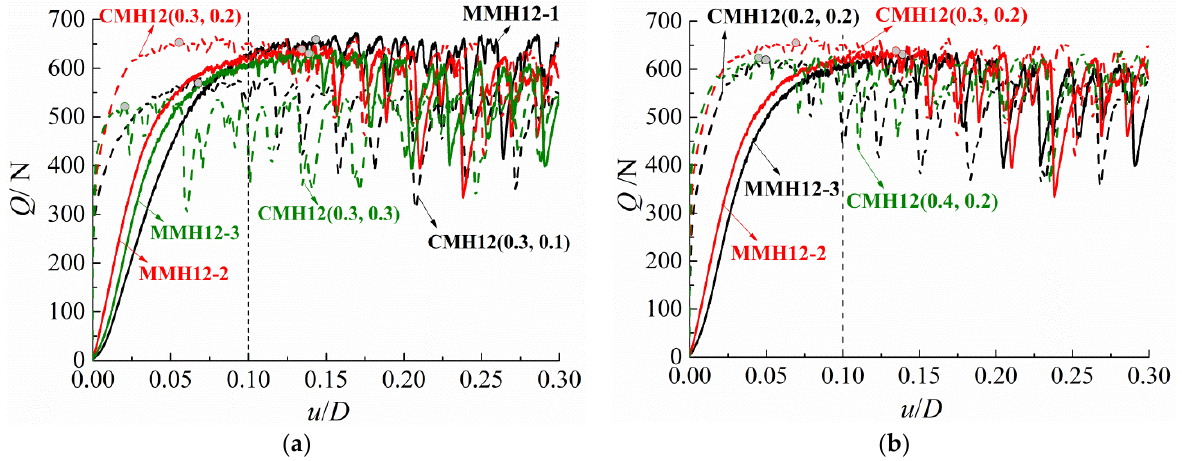
Figure 21. Post-cyclic monotonic and monotonic responses for different cyclic parameters: ( a ) Q mean / Q t = 0.3; ( b ) Q cyc / Q t =